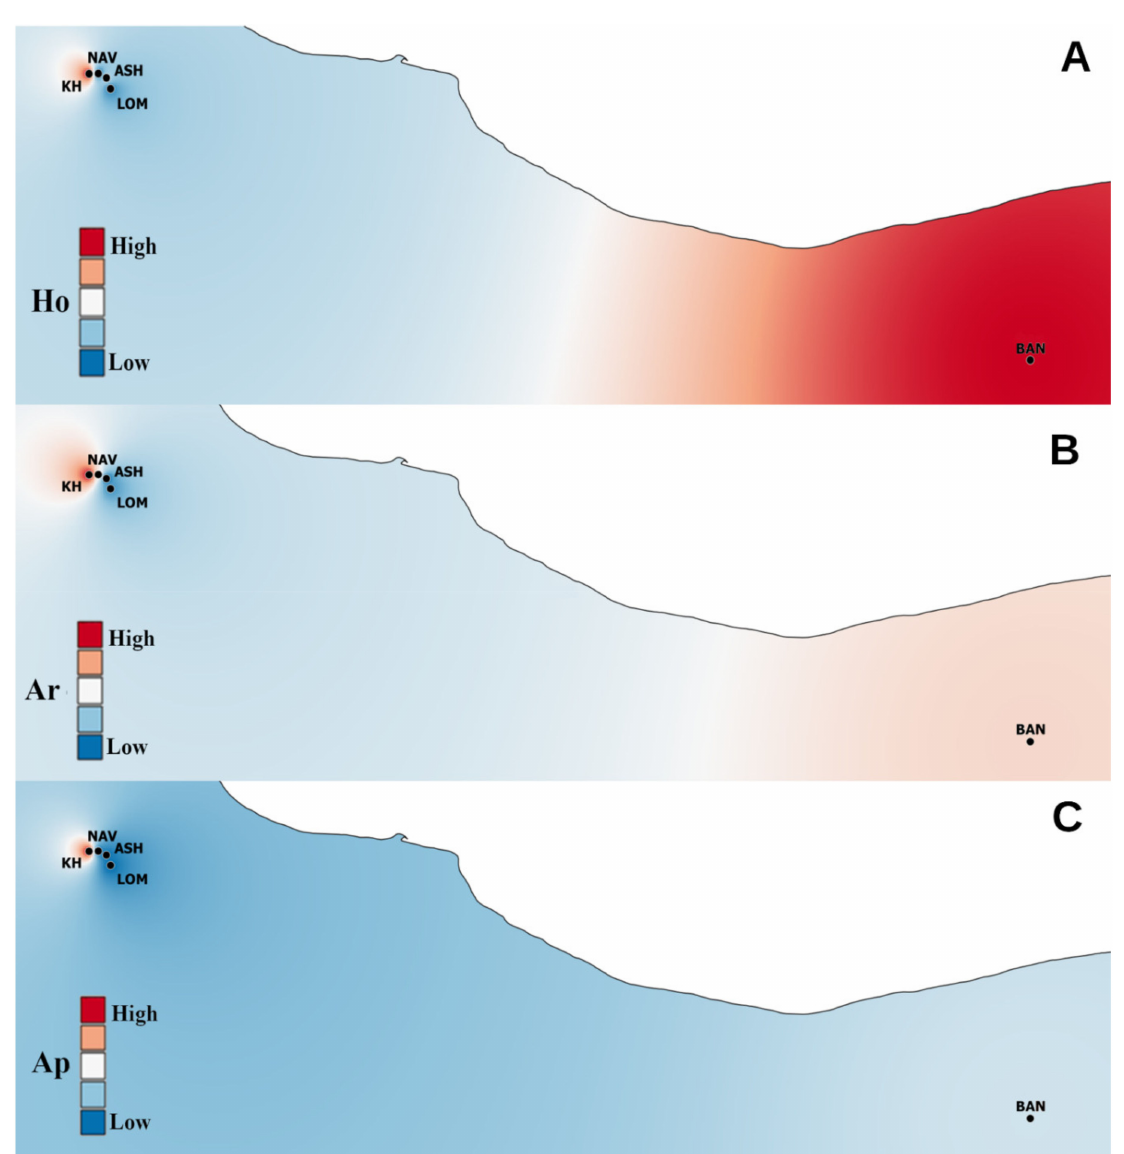
Figure 1. Maps of the genetic diversity of Sorbus aucuparia populations visualized by QGIS software. ( A ): expected heterozygosity (Ho), ( B ): allelic richness (Ar), ( C ): number of private alleles